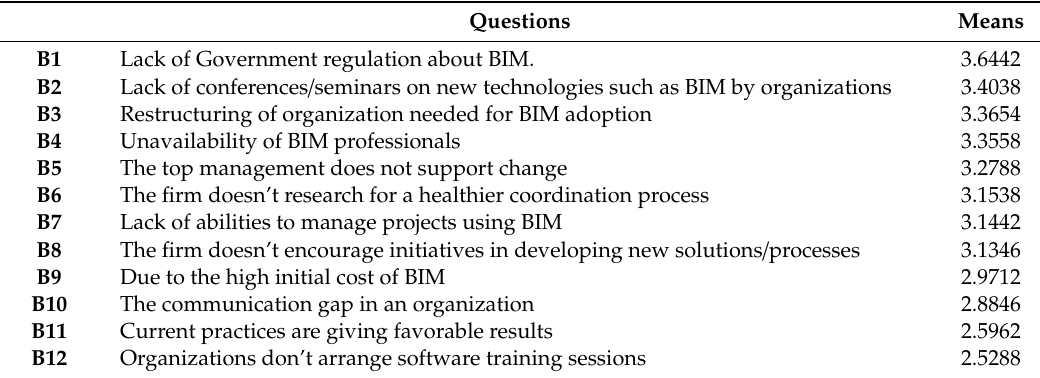
Table 4. Descriptive Frequencies.